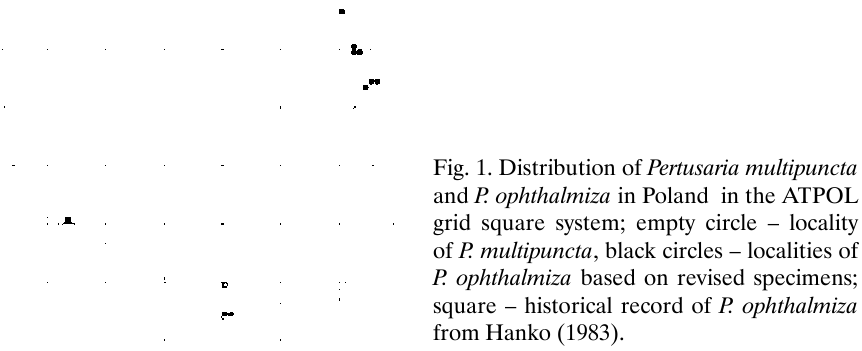
Fig. 1. Distribution of Pertusaria multipuncta and P. ophthalmiza in Poland in the atPOl grid square system; empty circle – locality of P. multipuncta , black circles – localities of P. ophthalmiza based on revised specimens; square – historical record of P. ophthalmiza from Hanko